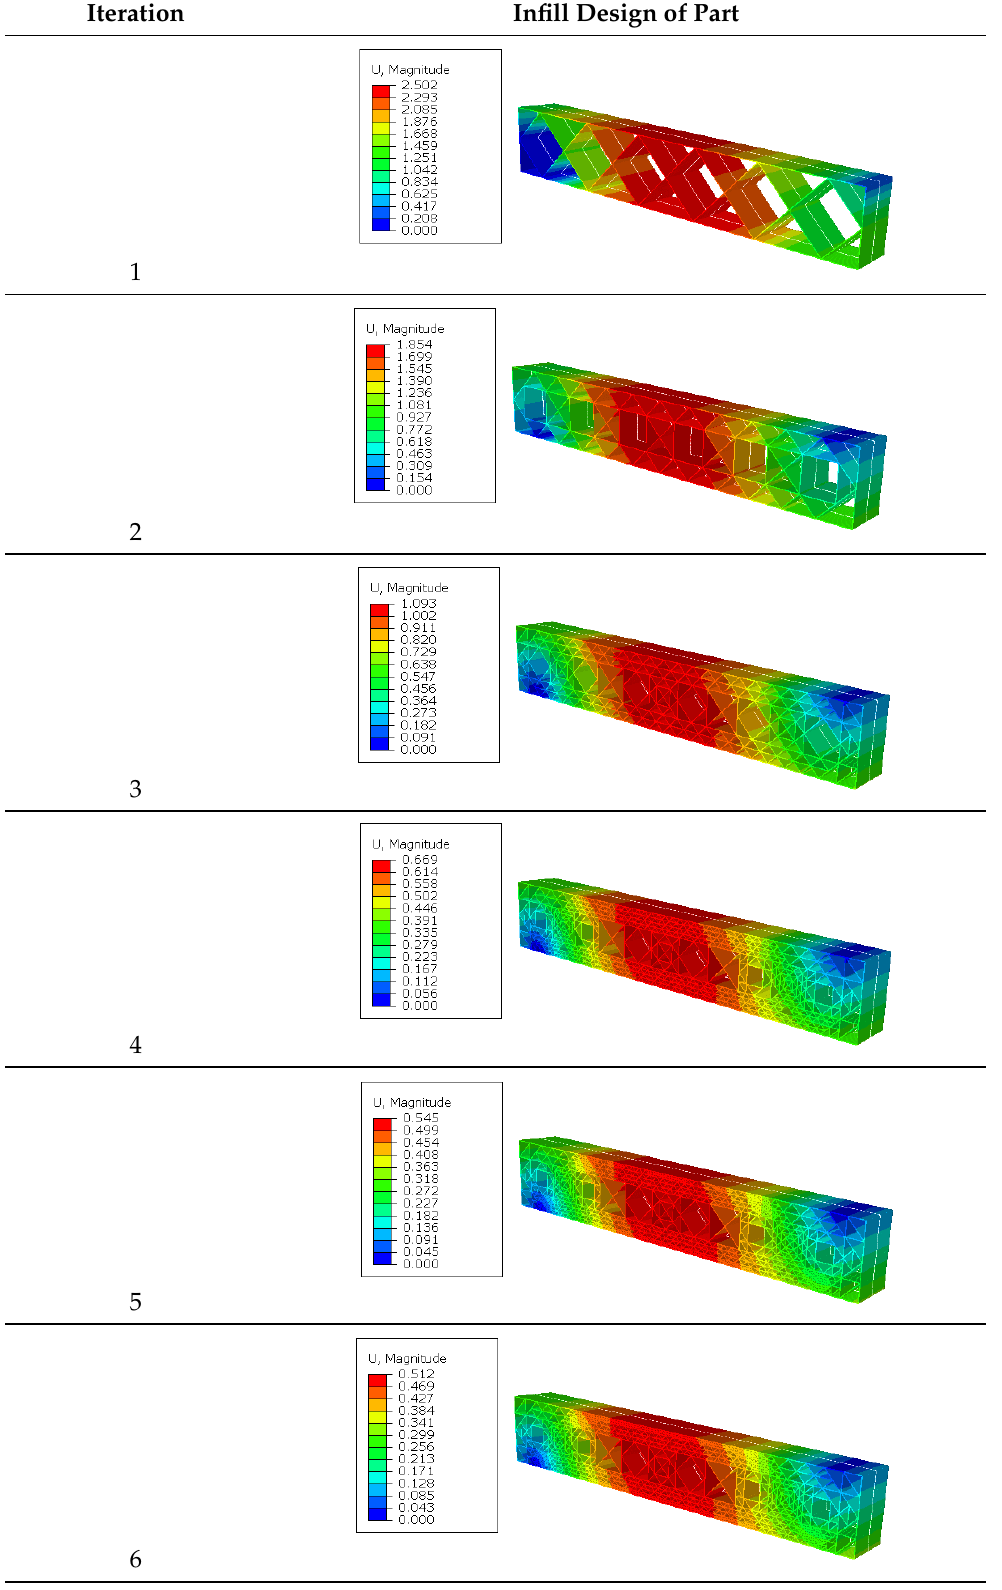
Table 3. Figures of maximum displacement for each iteration in Table 1 obtained in